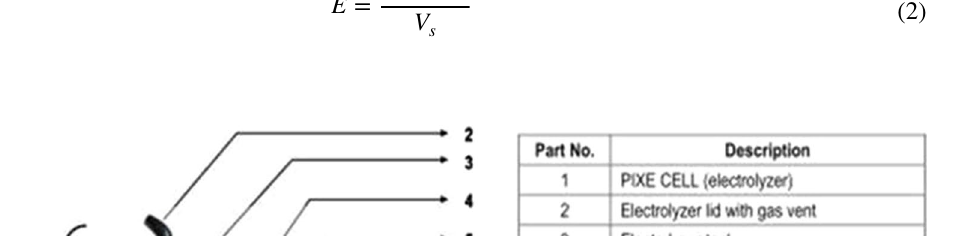
Fig. 2 EC evaluation device (RT Solutions, 2018) with description of various parts